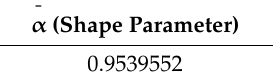
Table A1. MNIG Shape parameter α for Vector 1: Daqing, Urals, Marlim, SHCOMP, IBOV, NIFTY.